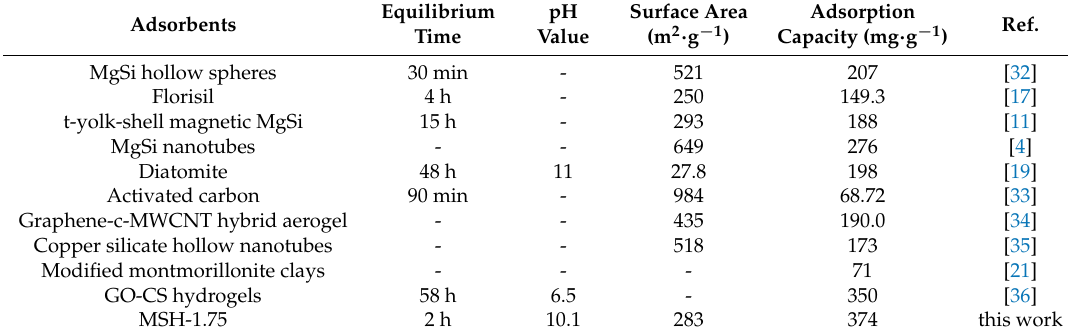
Table 4. Summaries of adsorption capacity of various adsorbents for MB under a certain